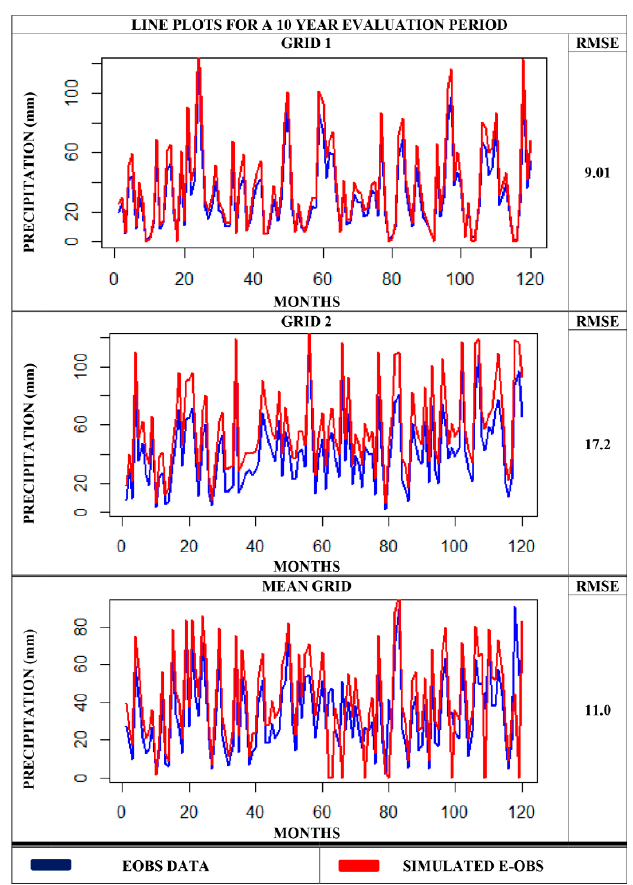
Figure 5. Evaluation of the bias correction method for a period of ten years (2001–2010).